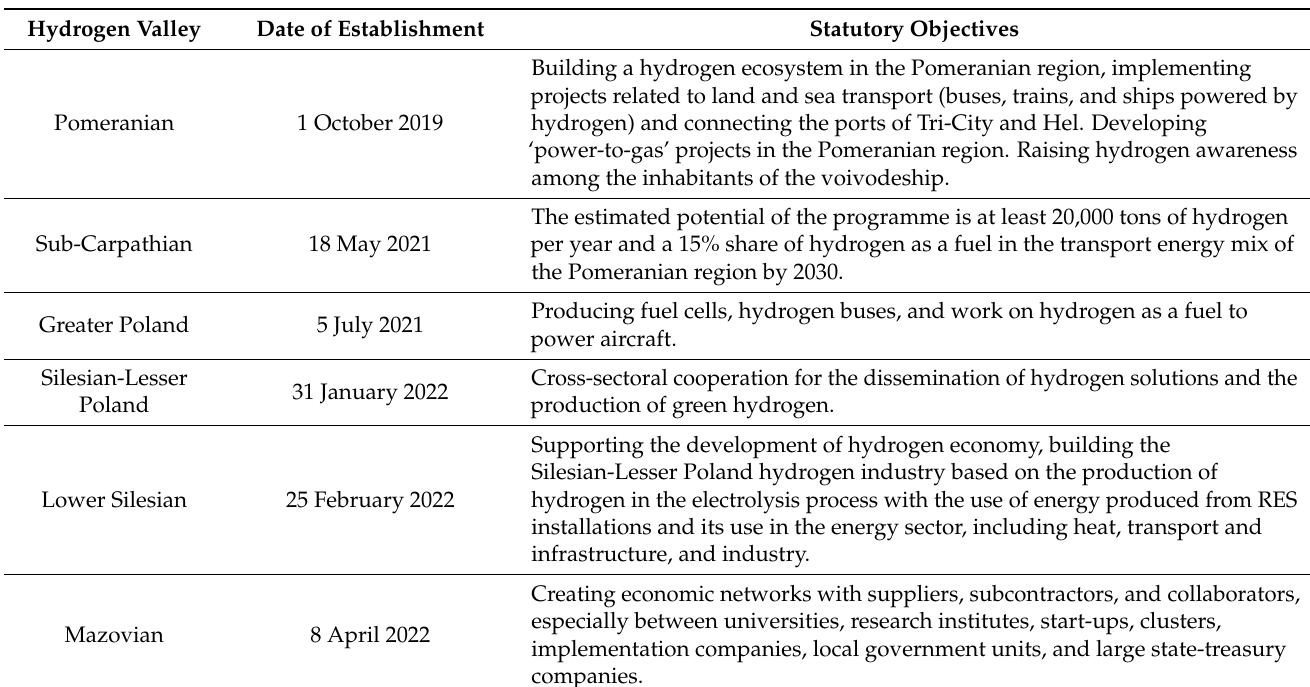
Table 1. Key hydrogen valleys in Poland (as of March